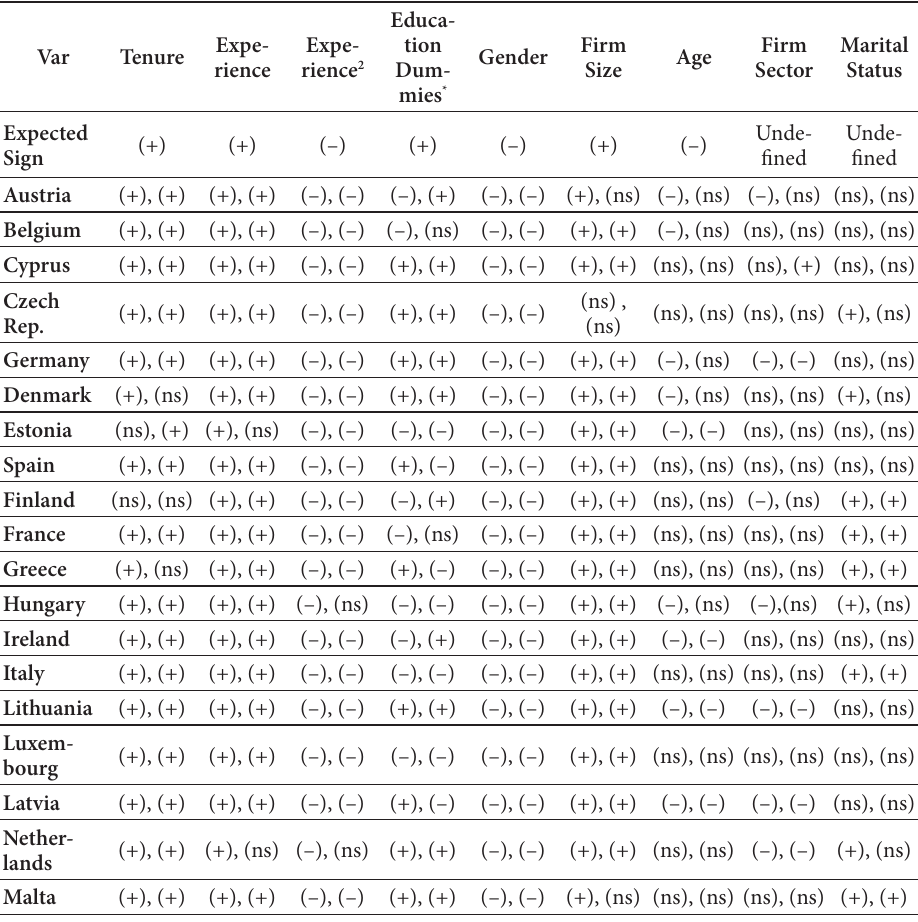
Table 3. Sign and statistical significance of typical determinants of wages (OLS, quantile – median regression) Var Tenure